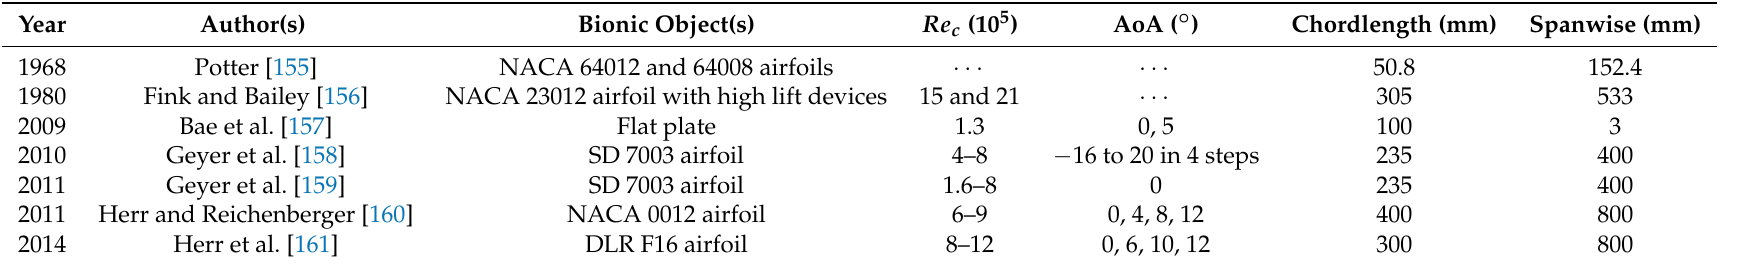
Table 8. Selected investigations of acoustic effect of porous material inspired noise reduction (“ · · · ” denotes “not